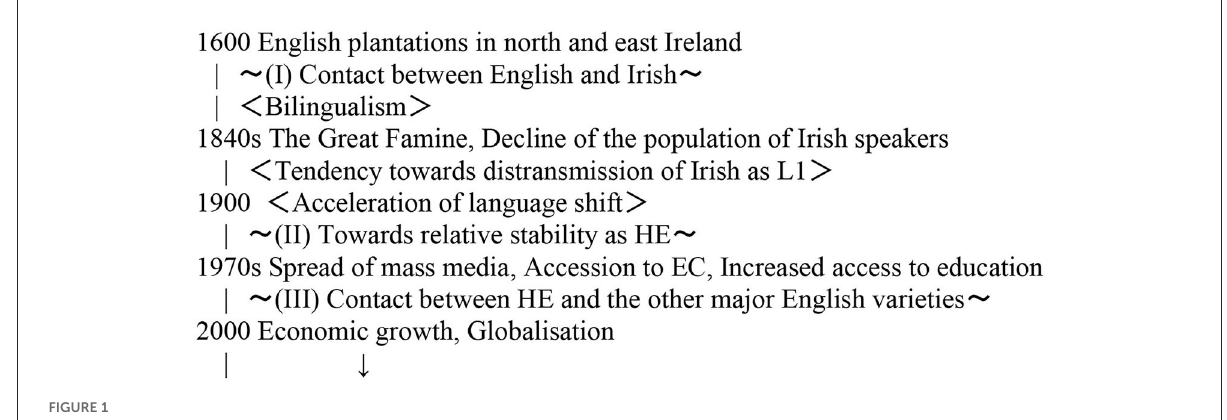
FIGURE1 Timeline of the sociohistorical background of